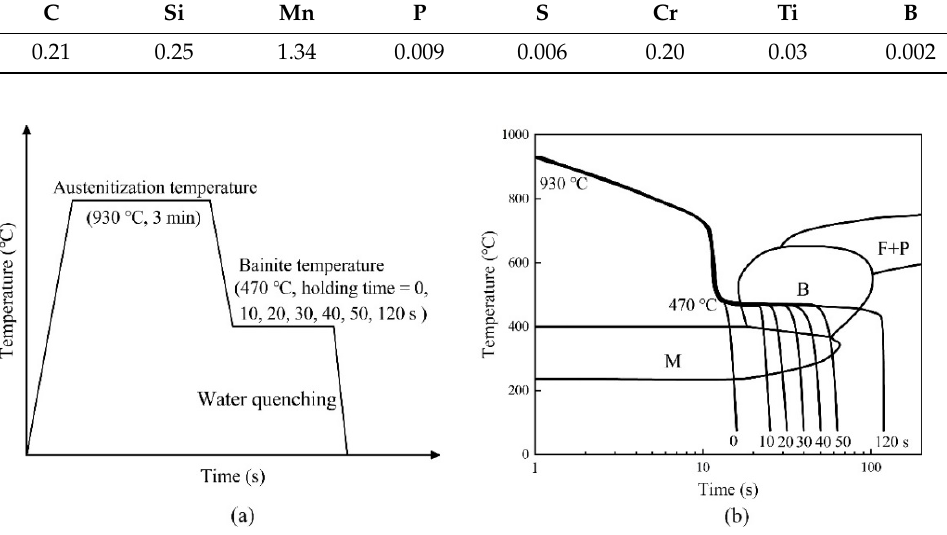
Figure 1. Heat treatment process in this study: ( a ) schematic diagram of heat-treatment procedures; ( b ) schematic diagram of time-temperature cycles with 22MnB5 CCT.